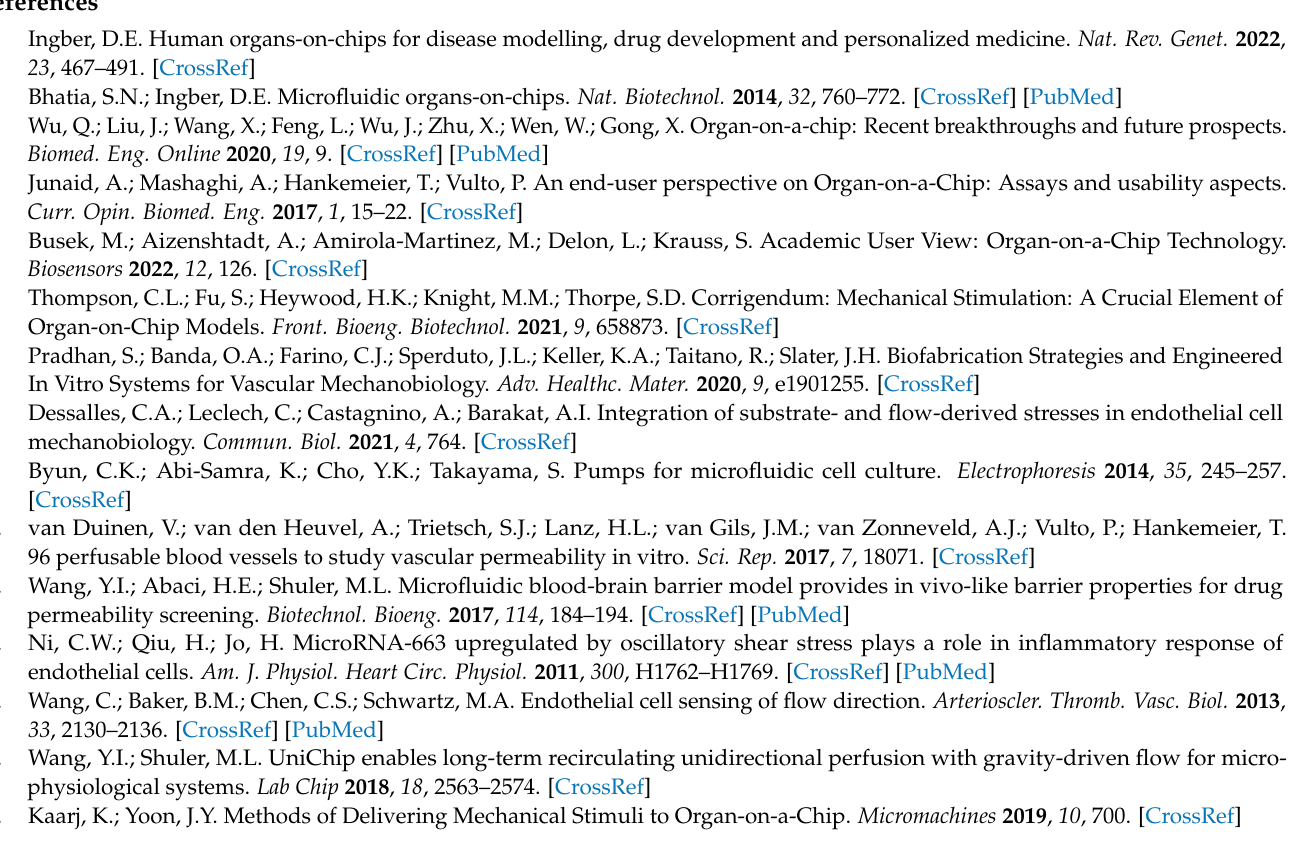
cuits, Figure S3: Typical total pressure increase using the custom PID-controller, Figure S4: Prediction of flowrates; Table S1: Software functionality, Table S2: Channel dimensions FCB; Video